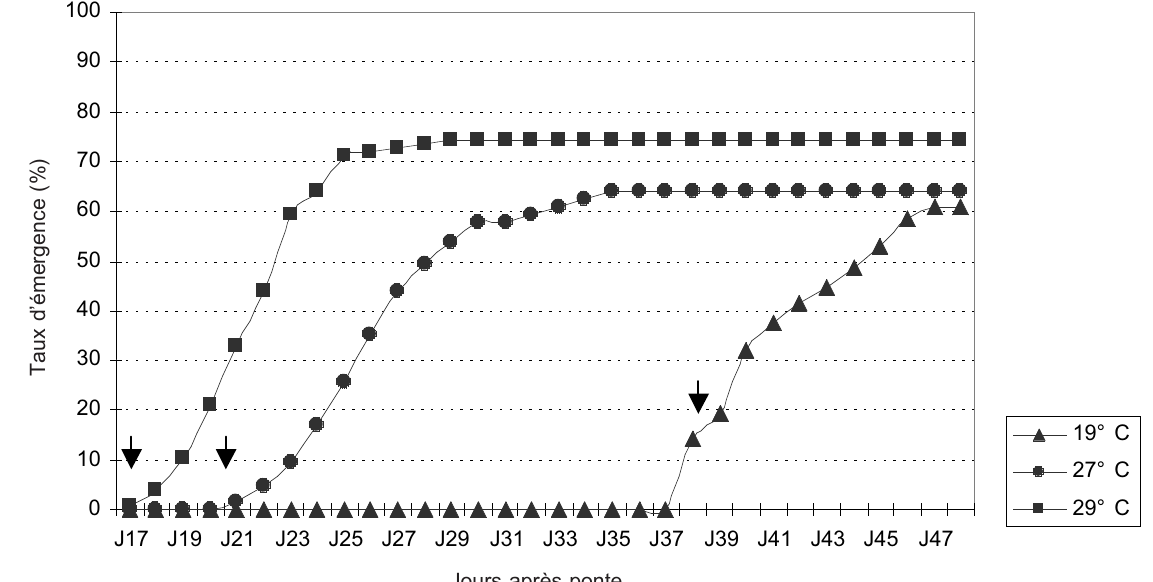
Jours après Fig. 5. – Chronologie d’émergence des adultes de C. f. strongylus en fonction de la température.